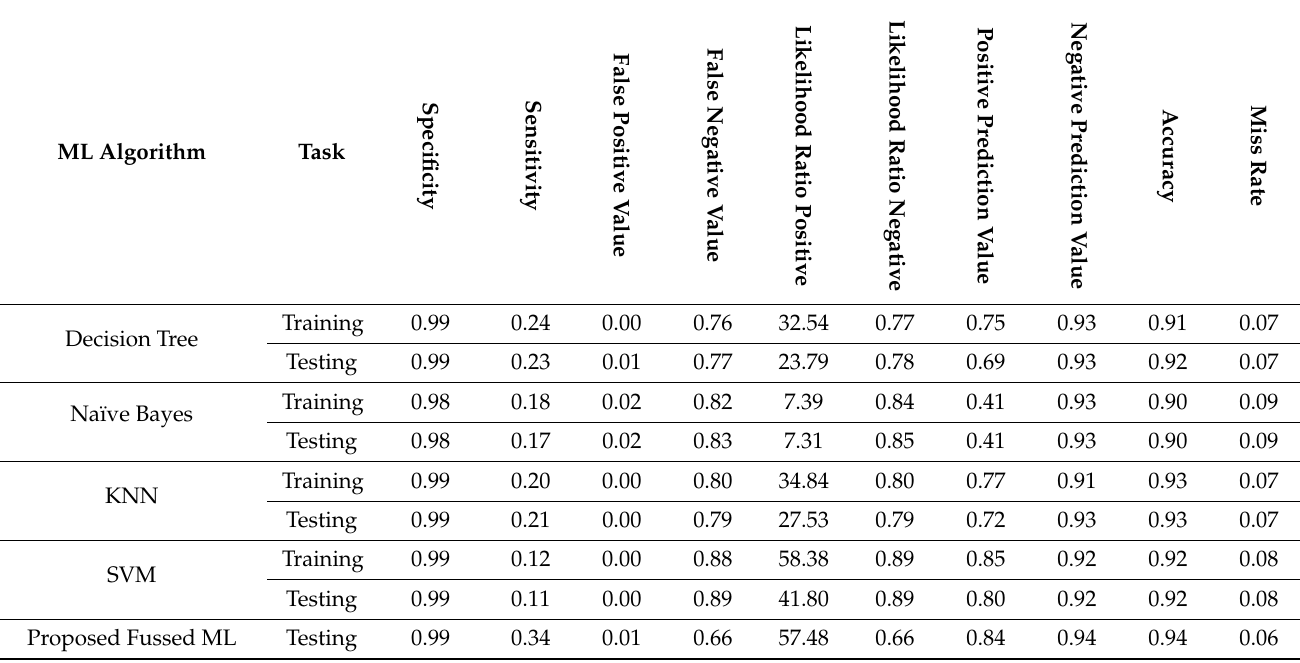
Table 13. Results of machine learning